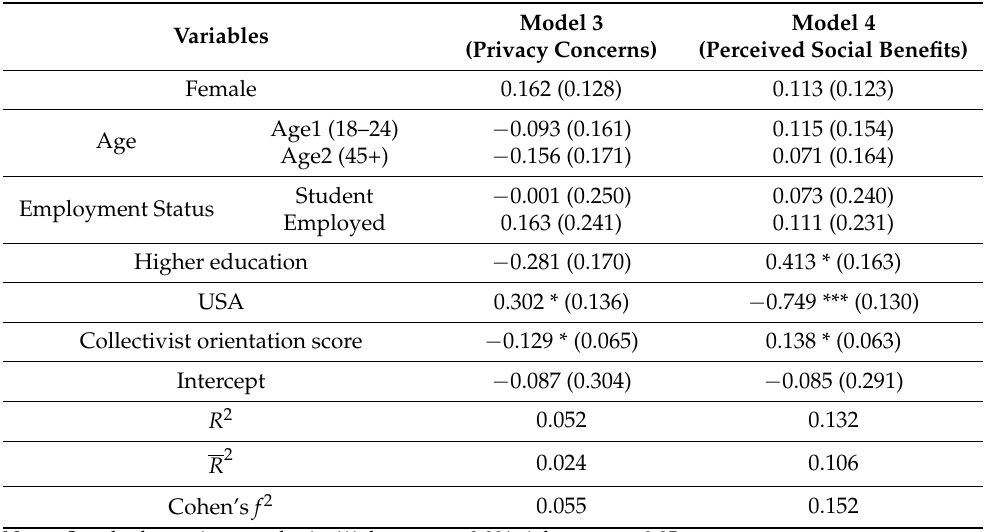
Table 13. Results of the linear regression models for the association between an individual’s sociode- mographic characteristics and privacy concerns (Model 3) and perceptions of social benefits (Model 4) ( n =